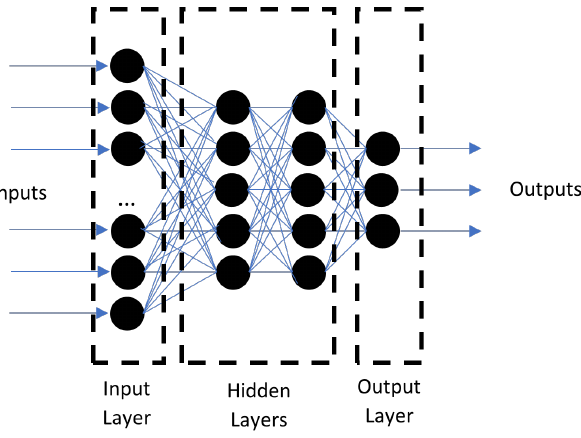
Figure 2. Neural network